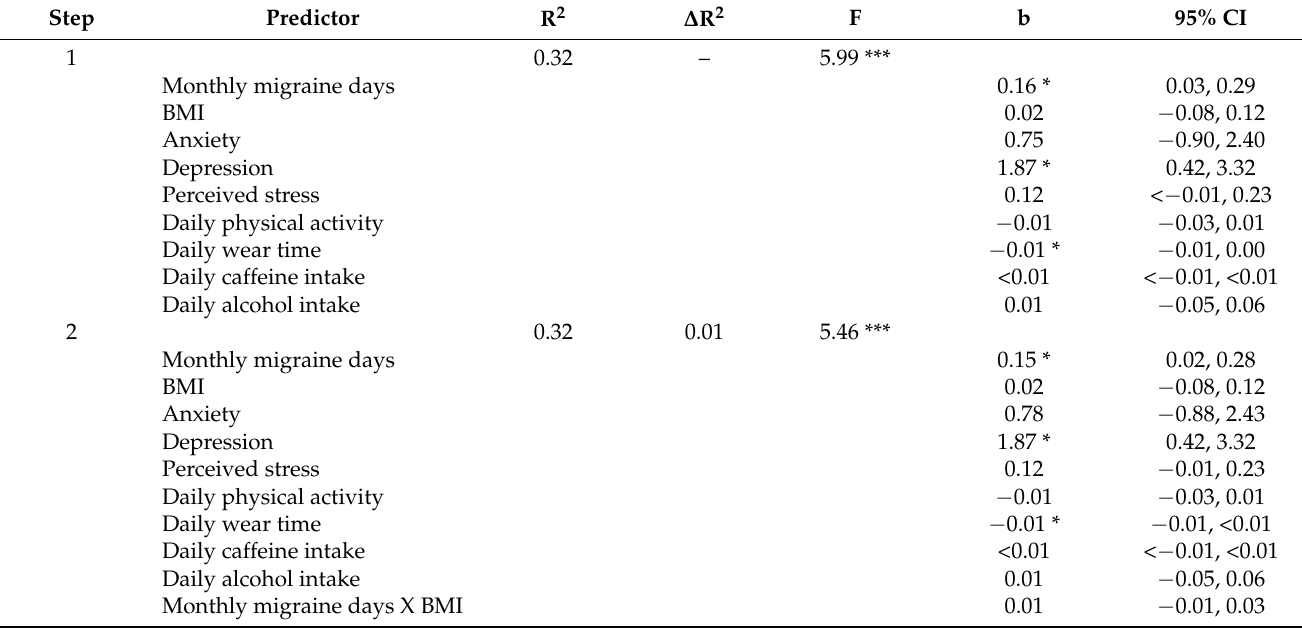
Table 4. Example hierarchical linear model results for migraine characteristics/clinical features predicting PSQI Global